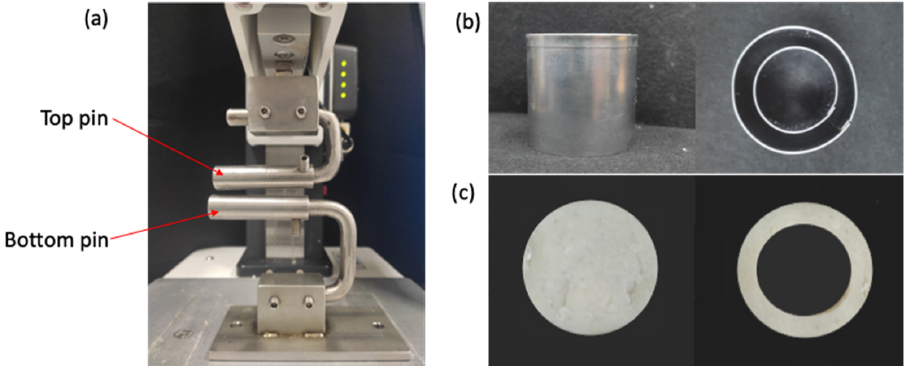
Figure 11. Schematic representation of the ring tensile test system ( a ), stainless steel stamp for the preparation of ring-shaped surimi gel ( b ), and the cylindrical and ring sample for the penetration and ring tensile test ( c ).